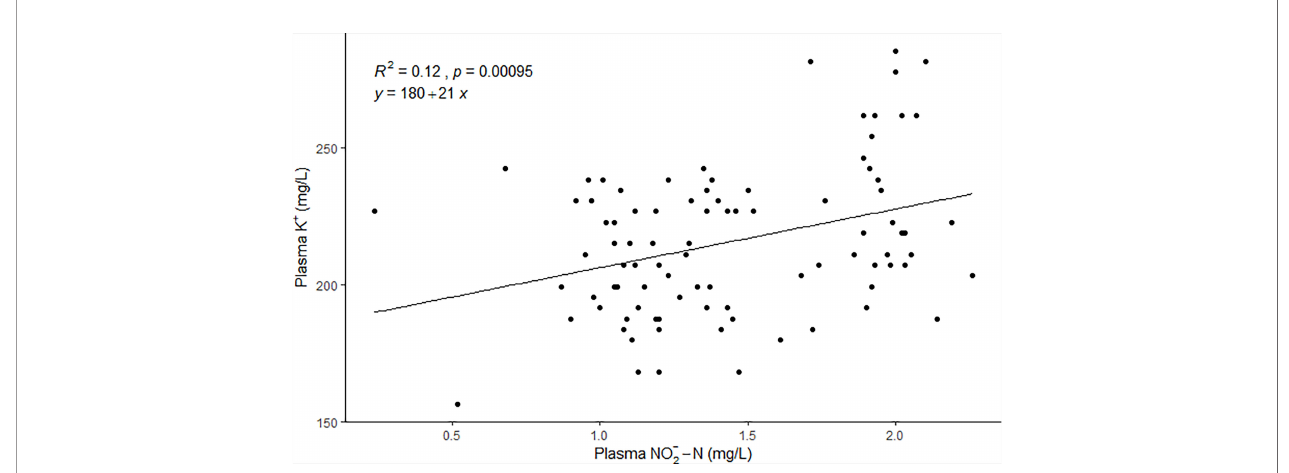
FIGURE 1 | The daily fl uctuating NO − 2 − N concentration (log scale) in the RAS water over the 22-month production period. Brackets and black dots illustrate the six weeks of sampling. The dashed horizontal line shows the FDIR (2004) recommended nitrite limit of 0.1 mg/L NO − 2 − N